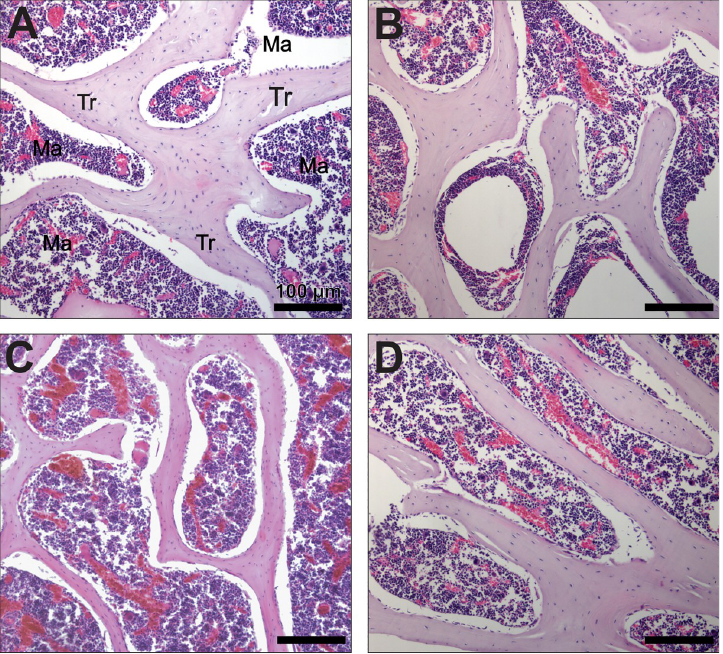
Fig 3. Bone histology of Artibeus lituratus females. Representive areas of trabecular bone in Non-pregnant (A), pregnant (B), lactating (C) and post-lactating (D) female Artibeus lituratus . Note that trabeculae are thinner in lactating female. Tr = trabecula, Ma = bone marrow. Sections were stained with hematoxylin and eosin.